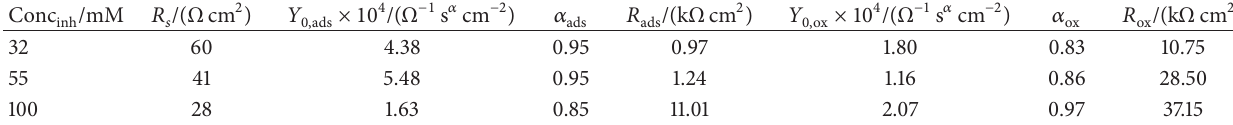
Table 3: Average inhibition efficiency at 22 ∘ C estimated from average values of 𝑅 𝑝 and 𝑅